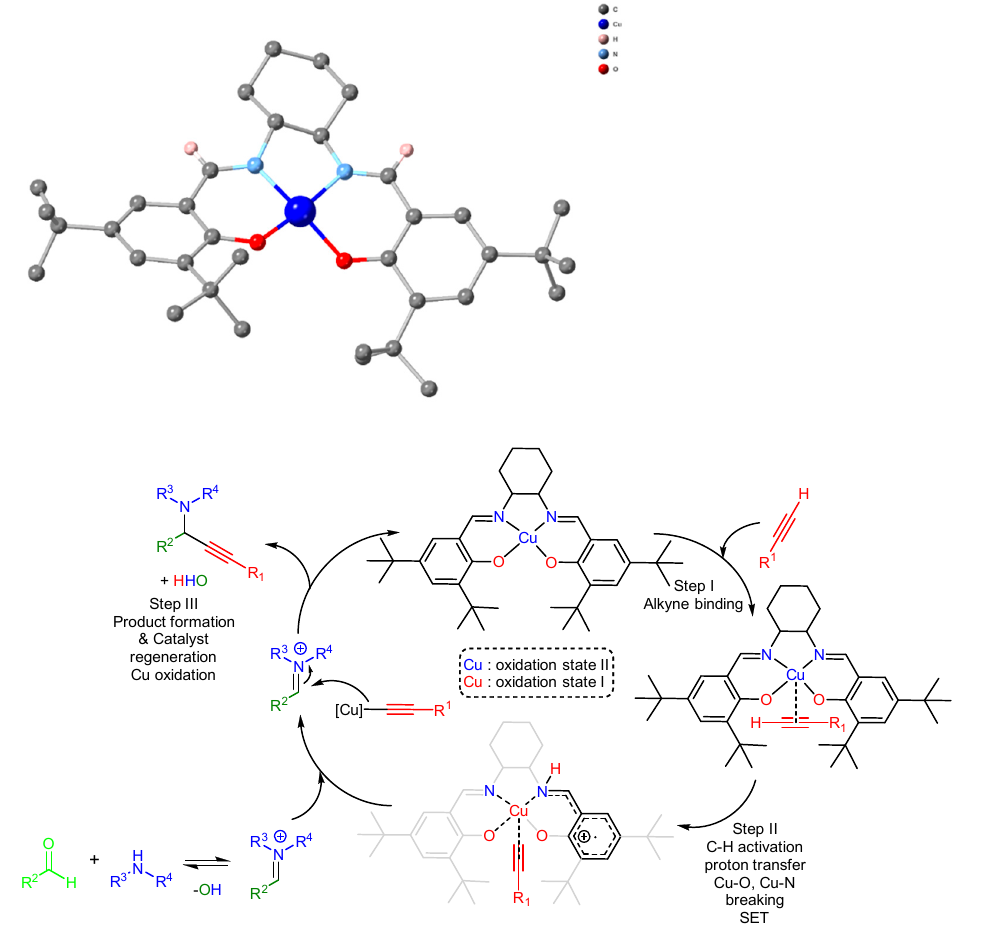
Scheme 58. The crystallographically characterised complex 10 and the possible reaction mechanism for A 3 coupling. Reproduced from ref. [124] with permission from the Royal Society of Chemistry.